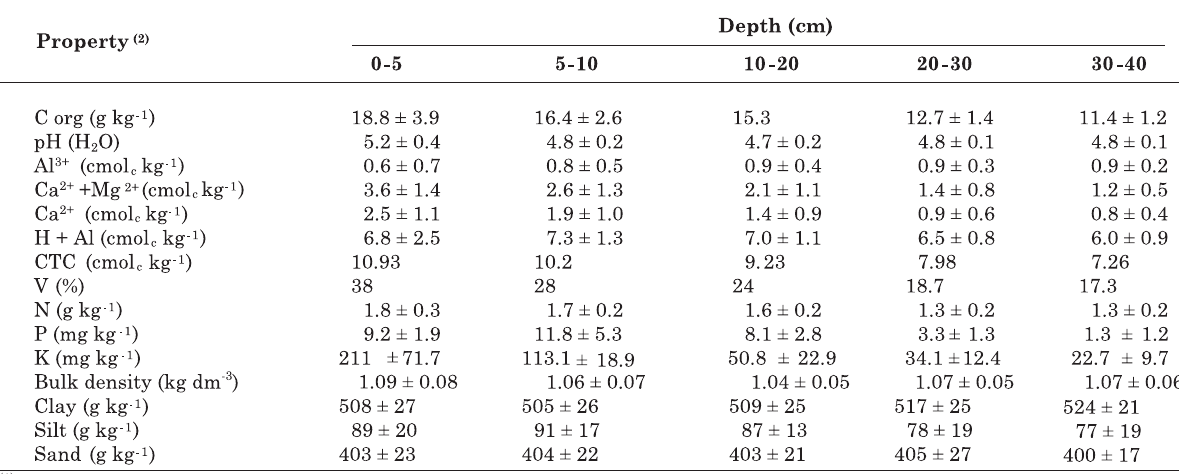
(1) Values correspond to the means and the standard deviation of the samples of each depth (n = 24) in the treatments considered in this study. (2) Properties evaluated by the methodology proposed by Embrapa